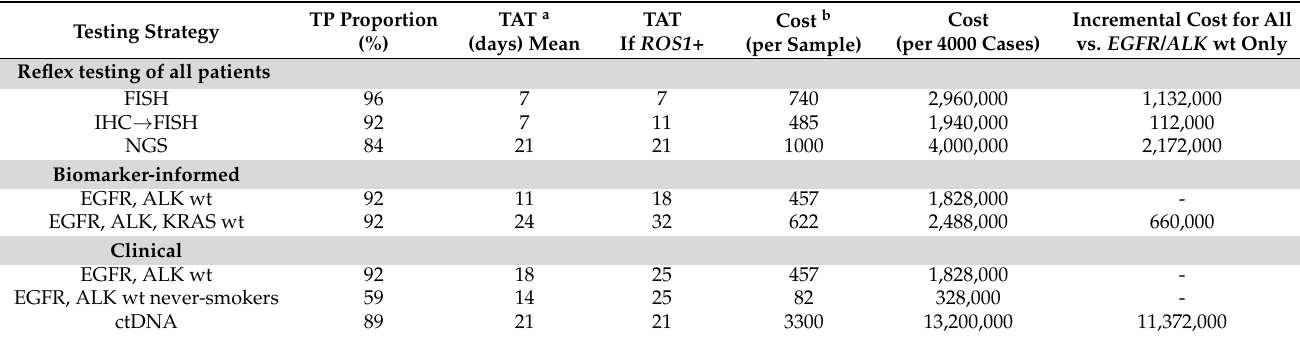
Table 2. Base case analysis of cost, turnaround time (TAT), and true-positive (TP) cases.